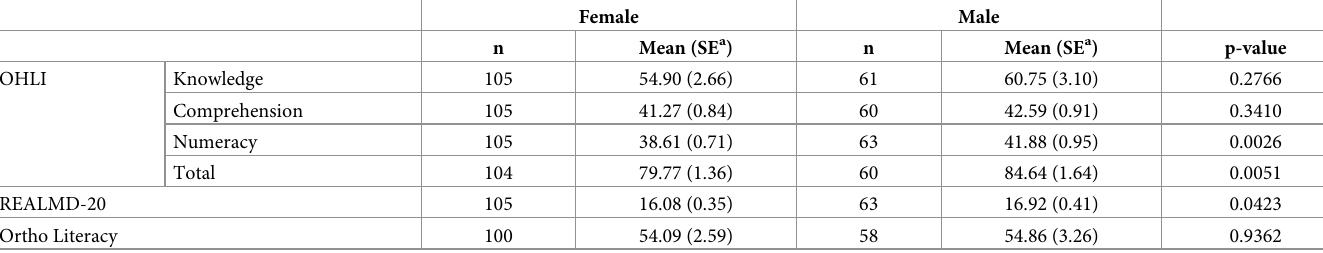
Table 3. Oral health and orthodontic literacy scales by gender.